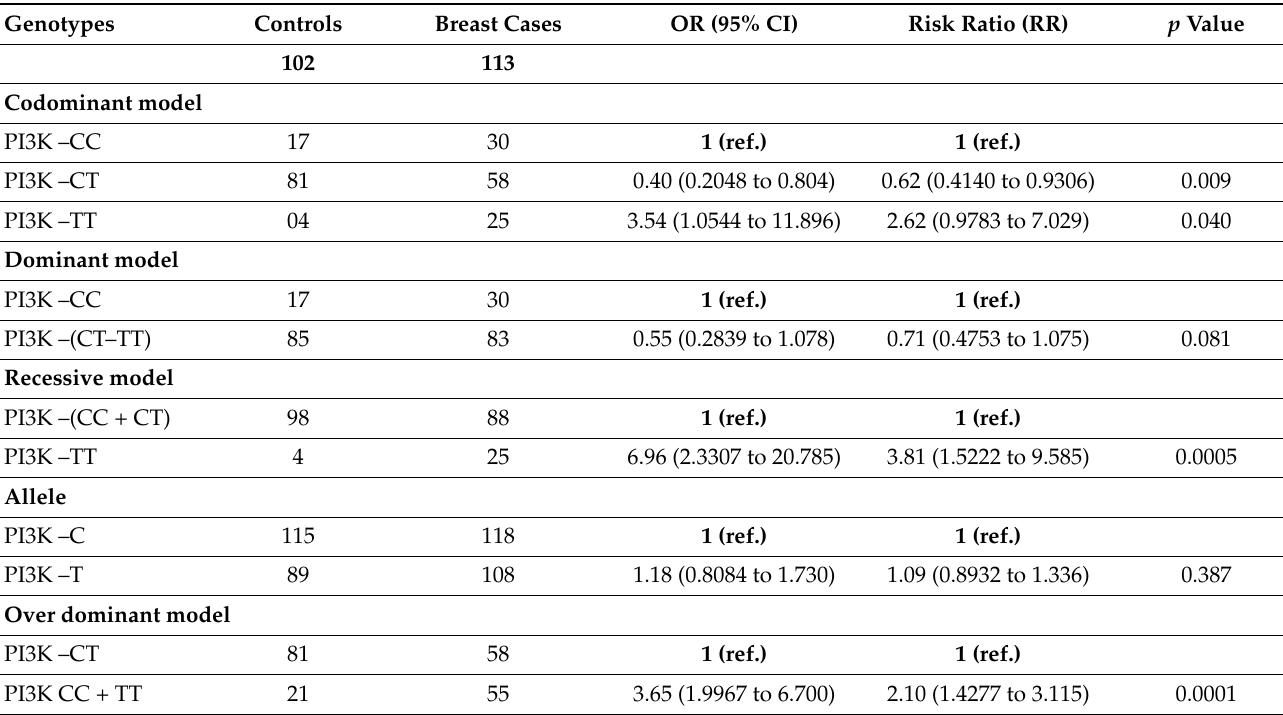
Table 5. Association of PI3K rs121913281 C > T genotypes with breast cancer cases.